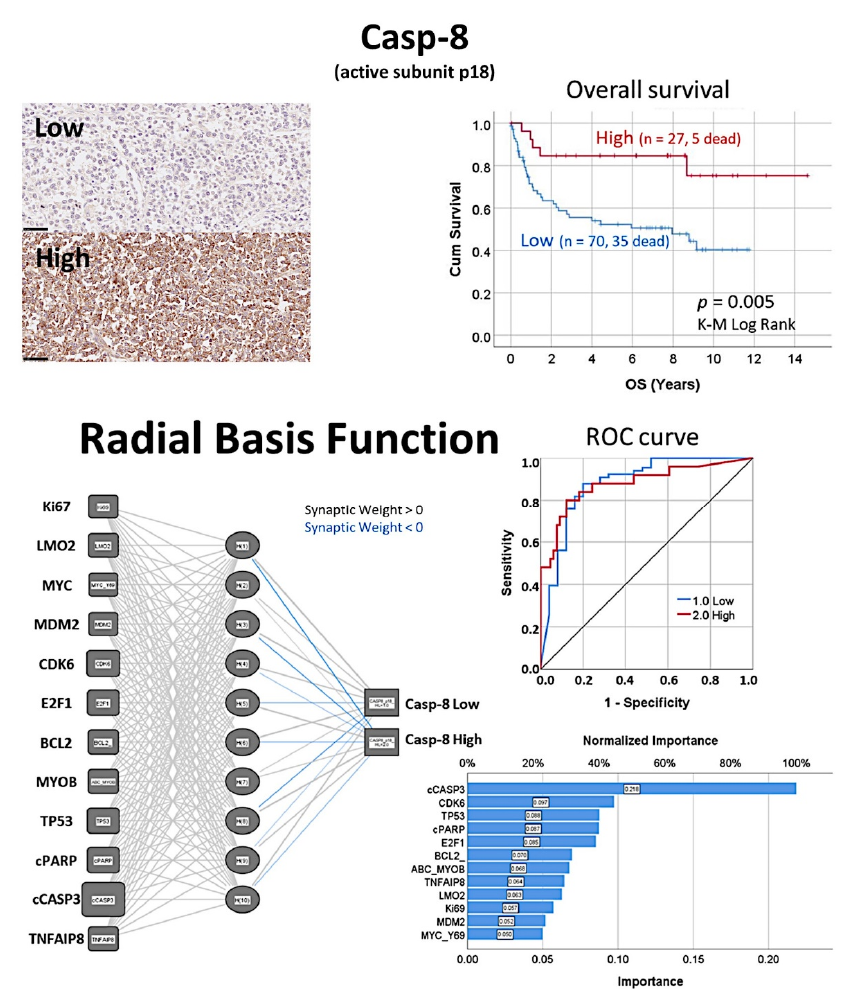
Figure 13. High caspase-8 correlated with favorable survival of diffuse large B-cell lymphoma patients. The protein levels of caspase-8 ( CASP8 ) were evaluated by immunohistochemistry, and later correlated with the survival of the patients. Two types of immunohistochemical staining were observed, low and high. In diffuse large B-cell lymphoma, high caspase-8 expression is associated with a favorable overall survival ( p = 0.005). Additionally, other markers of the capsase-8 pathway, including caspase-3, cleaved PARP, BCL2, TP53, MDM2, MYC, Ki67, E2F1, CDK6, MYB, LMO2, and TNFAIP8, were evaluated by immunohistochemistry and quantified using digital image analysis. Caspase-8 was successfully predicted by the pathway markers, both using conventional statistics and several machine learning techniques and artificial neural networks. Of note, after staining procedures, the immunohistochemical slides were digitalized and visualized (NanoZoomer S360 scanner and NDP.view2 viewing software, Hamamatsu KK.). Original magnification: 400× (scale bar = 50 um). OS, overall survival; ROC curve, the receiver operating characteristic curve.